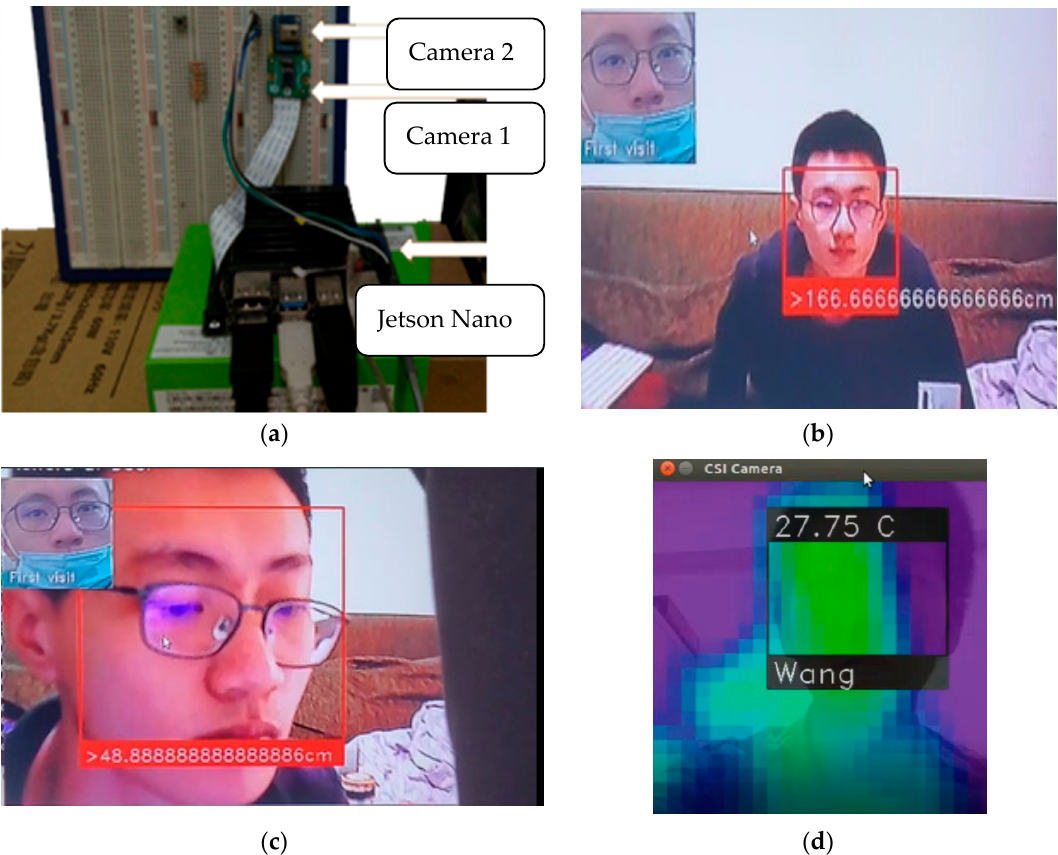
Figure 3. Implementation and verification of Artificial Intelligence of Things devices in the Jetson Nano Developer Kit for artificial-intelligence-based edge computing: ( a ) edge computing hardware, ( b ) facial recognition based on edge computing, ( c ) distance measurement for a recognized face, and ( d ) combined result of temperature and face recognition.